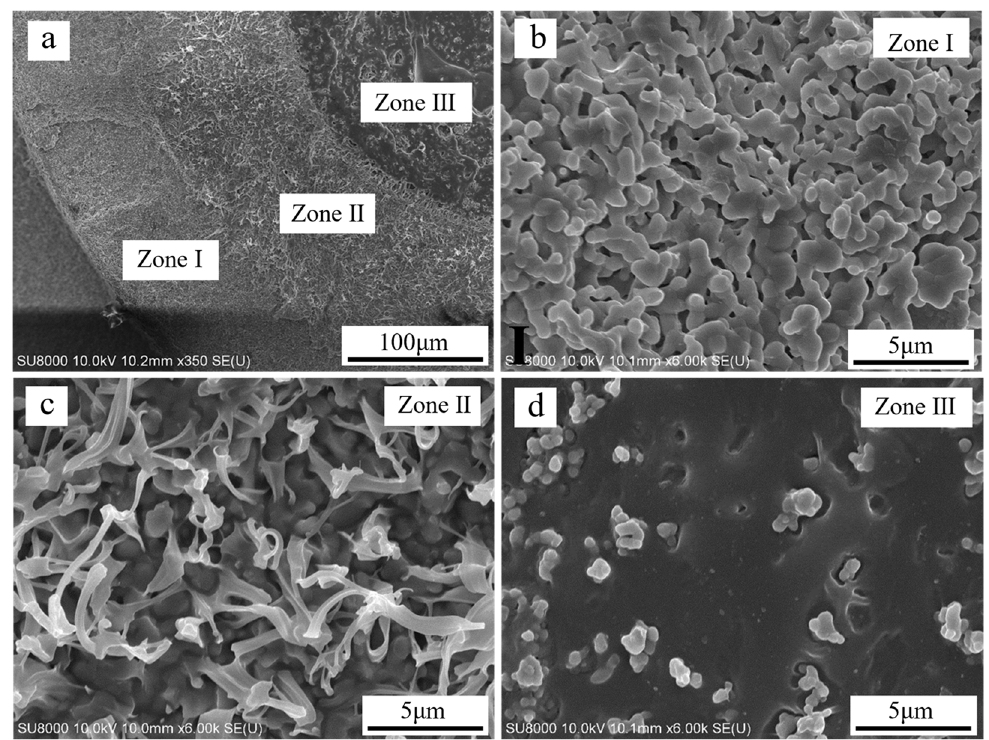
Figure 5. SEM micrograph of ( a ) gradient structure of β -TCP/PCL composite scaffolds: ( b ) β -TCP ceramic, ( c ) β -TCP matrix composite, ( d ) PCL matrix composite.